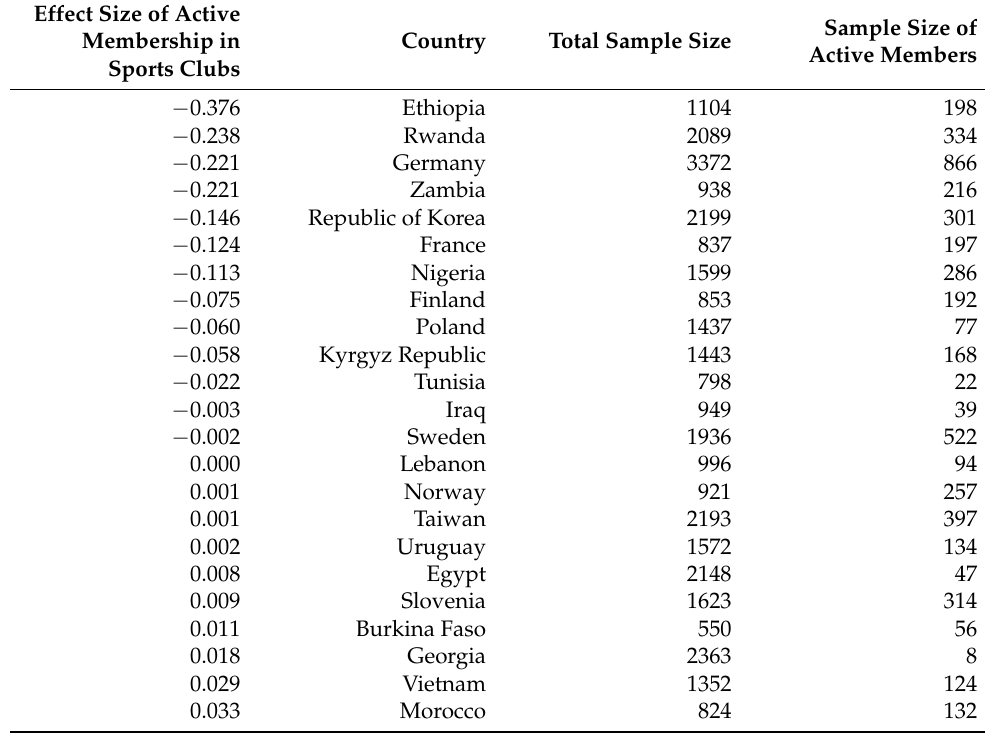
Table A2. List of country-specific effects for active membership in sports clubs on sexist gender ideologies for the group of men. Source: WVS-EVS